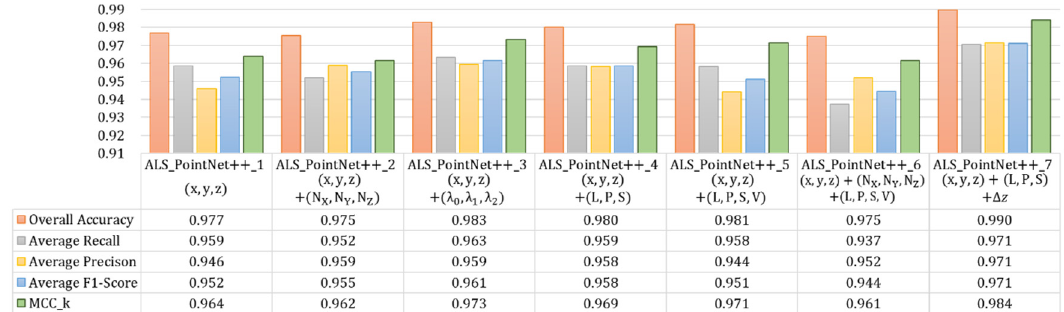
Figure 9. Comparison of classification results using PointNet++ with different handcrafted features on ALS point clouds.